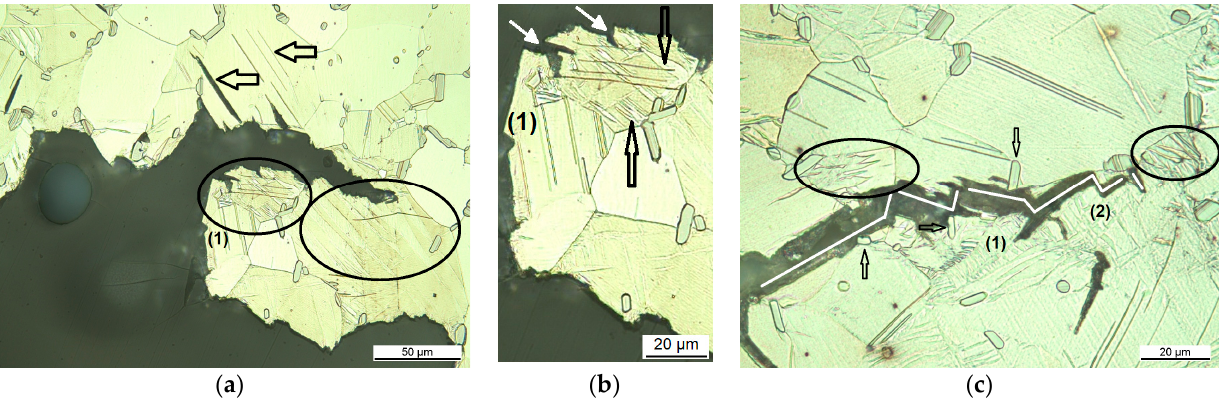
Figure 4. Cross ‐ sectional optical micrographs of the crack path in the Mg ‐ Dy ‐ Nd ‐ Zn ‐ Zr alloy C ‐ ring samples for the Figure 4. Cross-sectional optical micrographs of the crack path in the Mg-Dy-Nd-Zn-Zr alloy C-ring samples for the coarse ‐ grained microstructure: solution heat ‐ treated at 500 °C for 24 h ( a , c ), ( b ) magnified area from micrograph ( a ) circle coarse-grained microstructure: solution heat-treated at 500 ◦ C for 24 h ( a , c ), ( b ) magnified area from micrograph ( a ) circle (1).